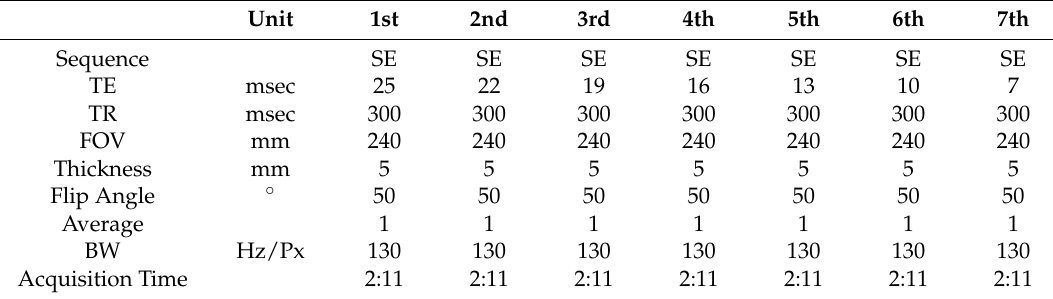
Figure 3. Images of the clinical study, ( a , b ) clinical phantom design and photographs; ( c , d ) the setup of the clinical study.